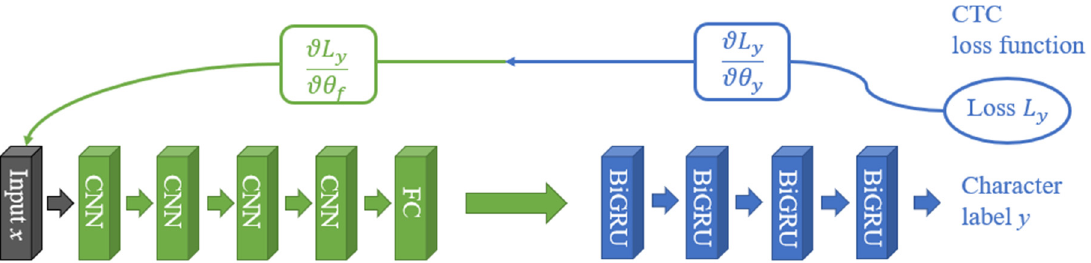
Figure 6. Architecture of the baseline model.